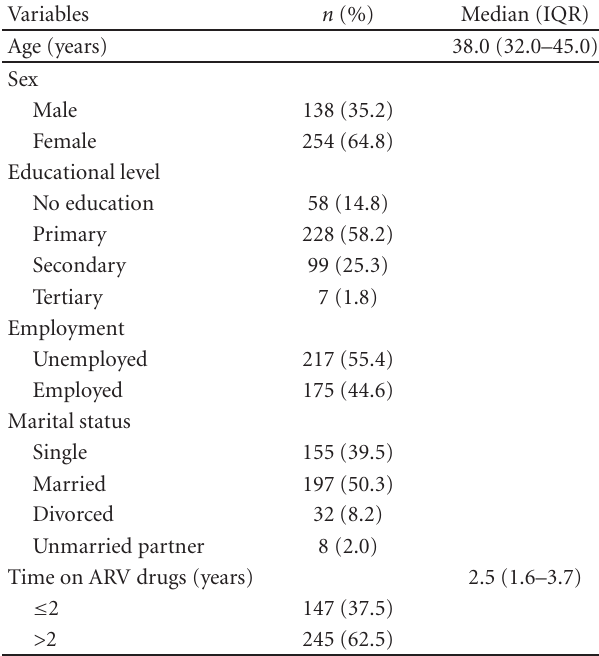
Table 1:Sociodemographic and treatmentcharacteristics( N = 392).